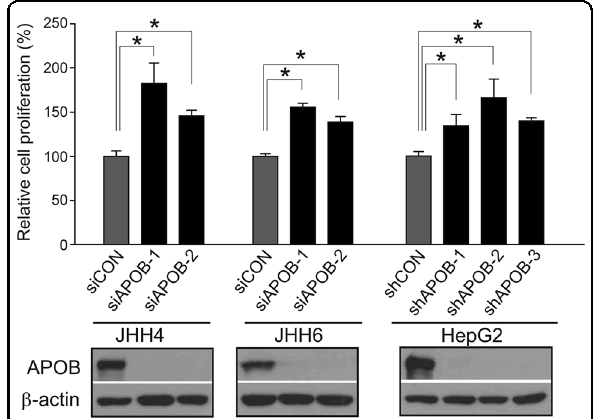
Fig. 5 APOB ablation increases the growth of HCC cells. Depletion of APOB by siRNAs or shRNAs signi fi cantly increased HCC cell proliferation. Two siRNAs and three shRNAs were used for silencing APOB expression in JHH4, JHH6, and HepG2 cells. The expression of APOB after treatment with siRNAs and shRNAs was measured with western blotting. * P < 0.01 by Student ’ s t